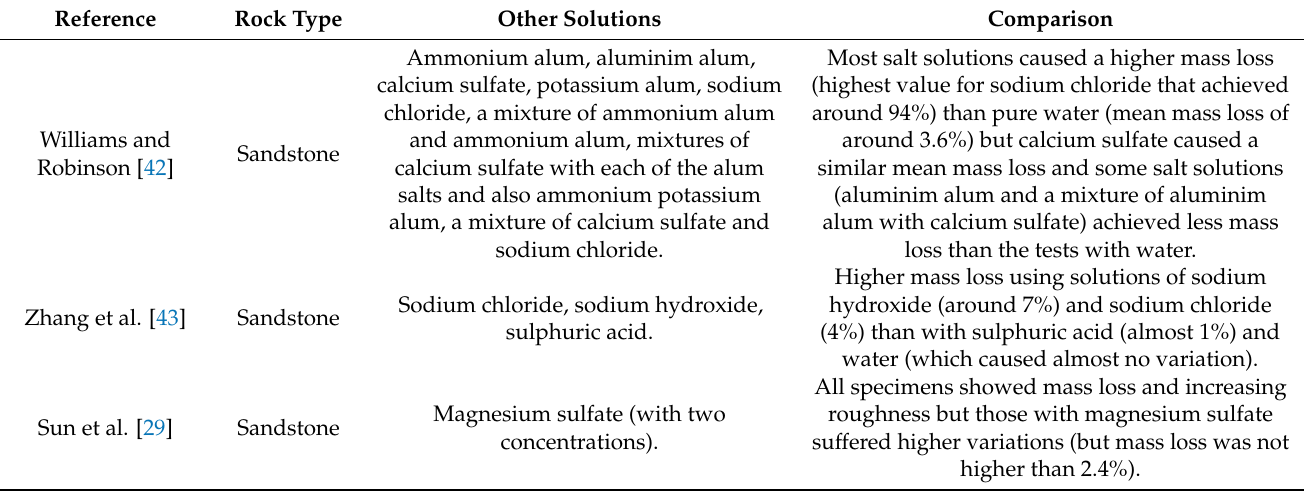
Table 3. Analysis of comparative studies of freeze–thaw tests with water and other